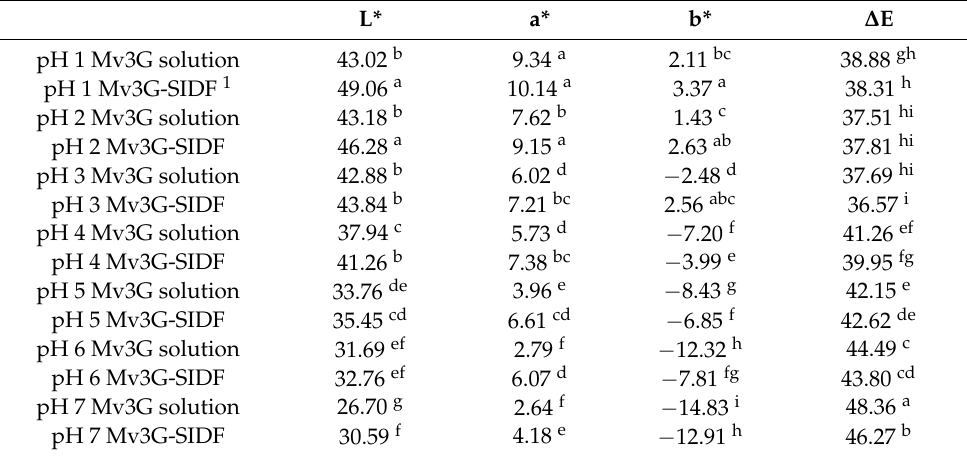
Figure 1. Color change of SIDF-Mv3G and Mv3G. SIDF-Mv3G: the stable system solution of soybean insoluble dietary fiber and malvidin-3- O -glucoside; Mv3G: malvidin-3- O -glucoside solution. Table 2. Color measurement